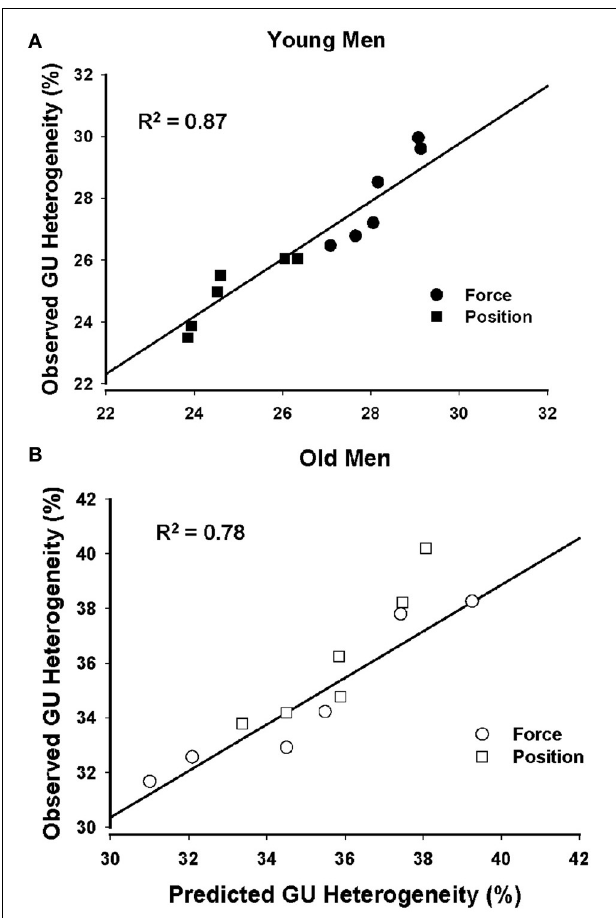
FIGURE 3 | Prediction of glucose uptake heterogeneity of young and old men. Glucose uptake heterogeneity was strongly predicted by the MVC force of the knee extensor muscles for the young men (A) and by the muscle volumes of the knee extensors for the old men (B)